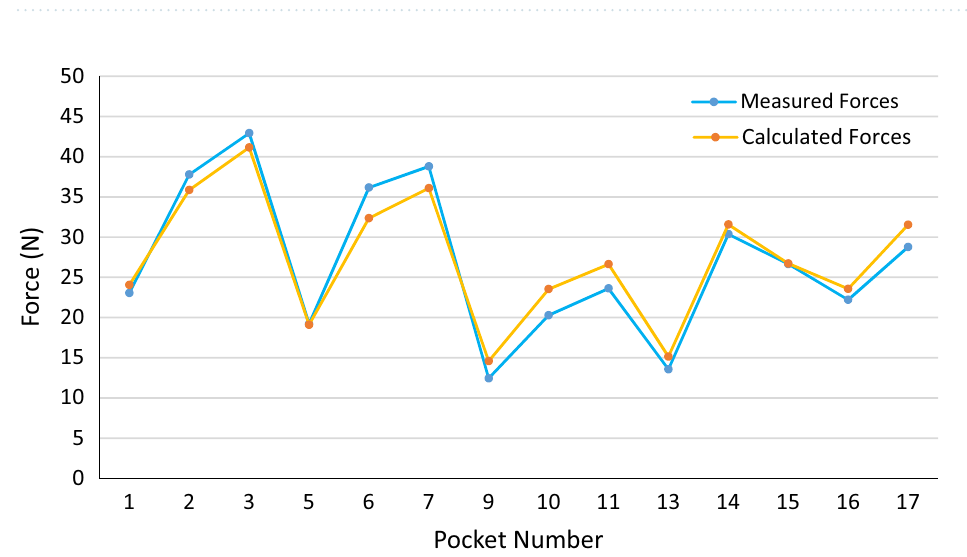
Figure 12. Measured and calculated push-out forces in PA46 cages.